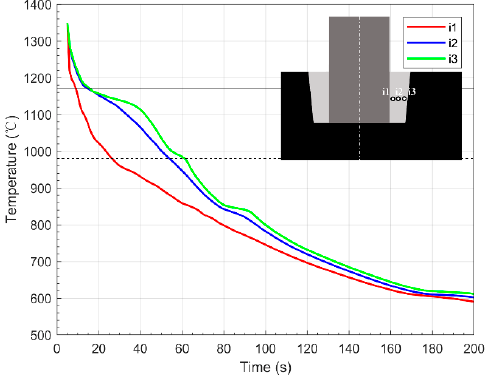
Figure 17. The cooling cures of i1, i2, and i3 in cast iron.